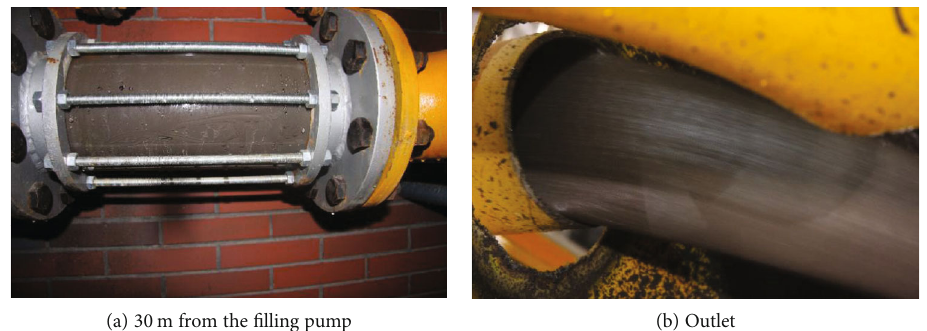
Figure 11: The fl ow state of the paste in the